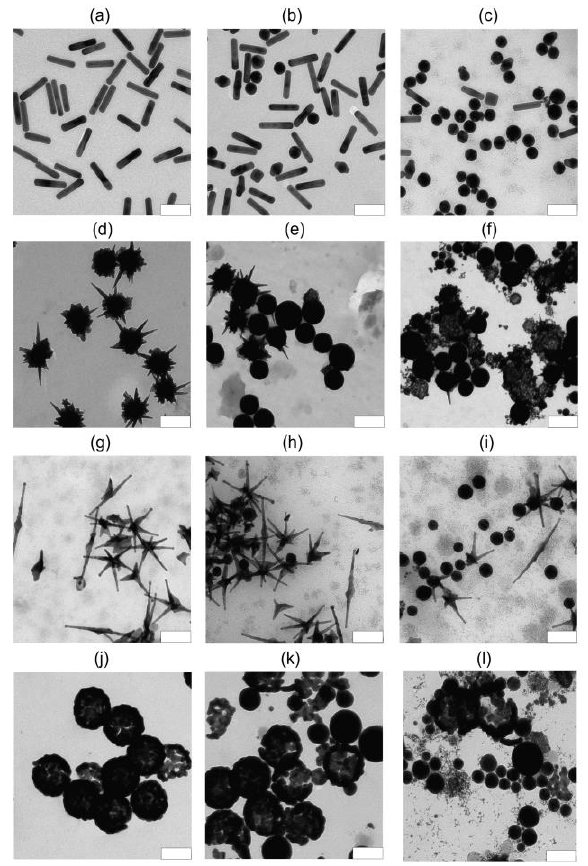
Figure 6. TEM images of AuNRs nanoparticles before (left column) and after (middle and right columns) PM. AuNRs — F = 0 ( a ), 40 ( b ), and 520 mJ/cm 2 ( c ). AuNSTs — F = 0 ( d ), 260 ( e ), and 1040 mJ/cm 2 ( f ). AuNAs — F = 0 ( g ), 65 ( h ), and 260 mJ/cm 2 ( i ). AuNSHs — F = 0 ( j ), 130 ( k ), and 520 mJ/cm 2 ( l ). Scale bars are 100 nm ( a – f , j – l ) and 200 nm ( g – i ).